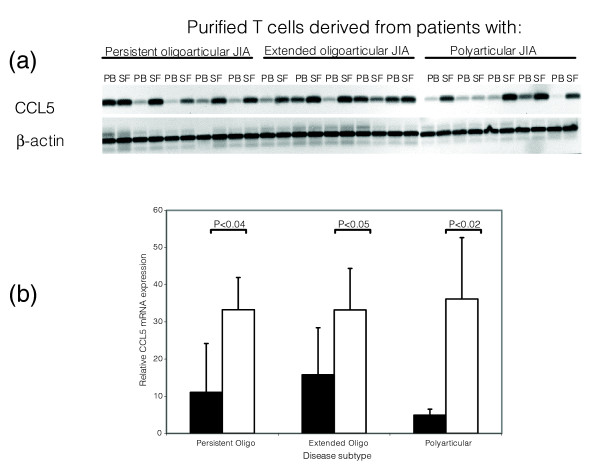
High expression of mRNA for CCL5 in purified T cells from the joint of patients with juvenile idiopathic arthritis (JIA). (a) Oligonucleotide-specific probing of blotted amplification products of CCL5 after RT-PCR from paired sets of purified T cells from 15 JIA patients (5 persistent oligoarticular, 5 extended oligoarticular, 5 polyarticular). (b) Relative levels of CCL5 mRNA in purified T cells from each JIA subgroup. Black bars, peripheral blood (PB) CD3+ cells; white bars, synovial fluid (SF) CD3+ cells. Bars represent mean values; error bars one standard deviation.